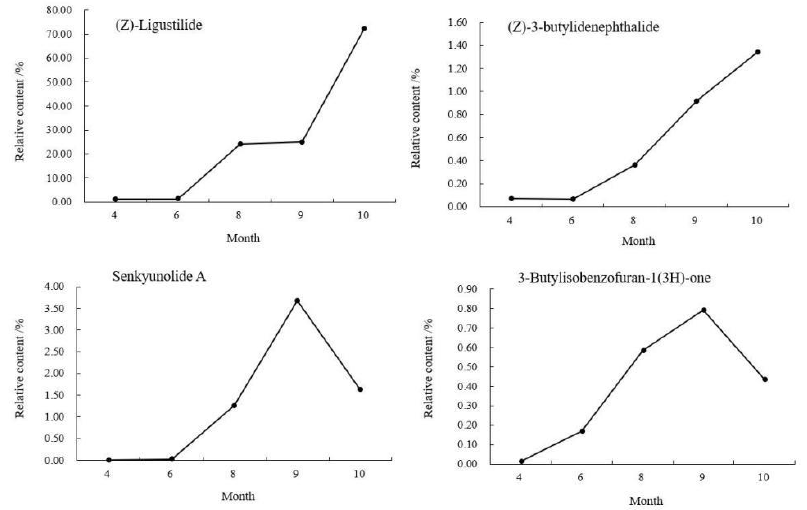
Figure 3. Changes of chemical components in the head of A. sinensis in different periods.